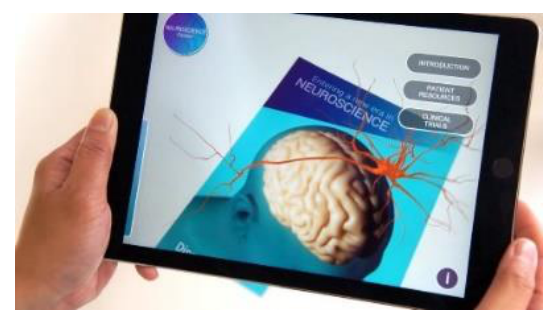
Figure 2 . Augmented Reality ( AR ) Neuroscience Pipeline Teaser - Polygon Medical Animation Source : https :// i . vimeocdn . com / video / 632884557_1280x720 .